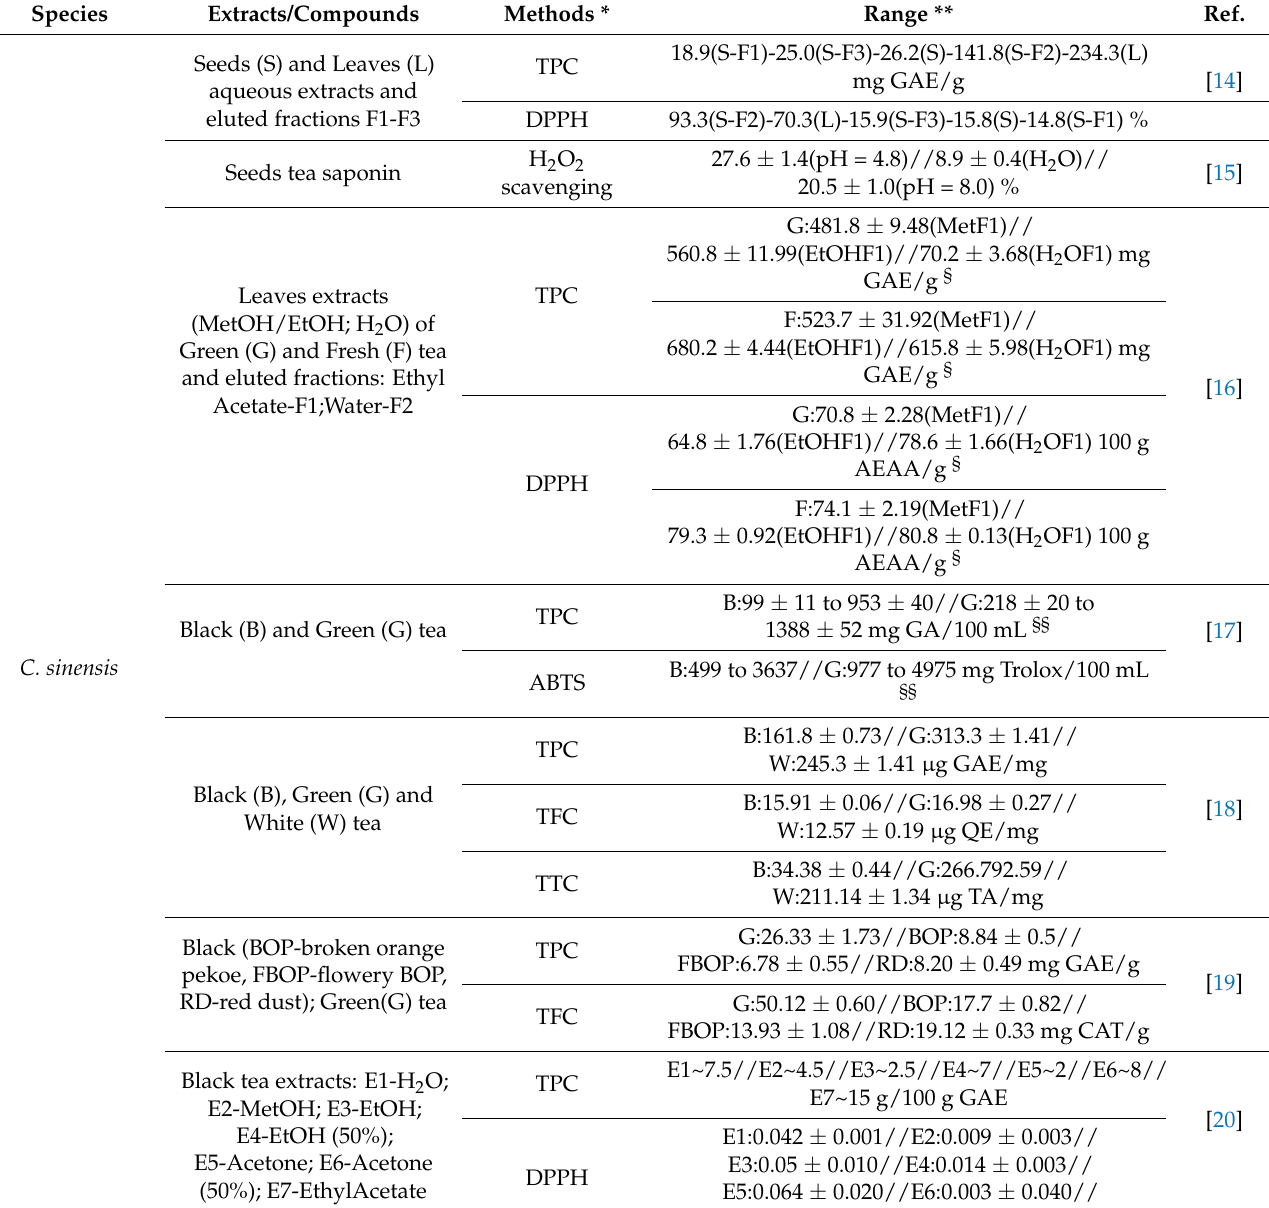
Table 1. Antioxidant properties of Camellia